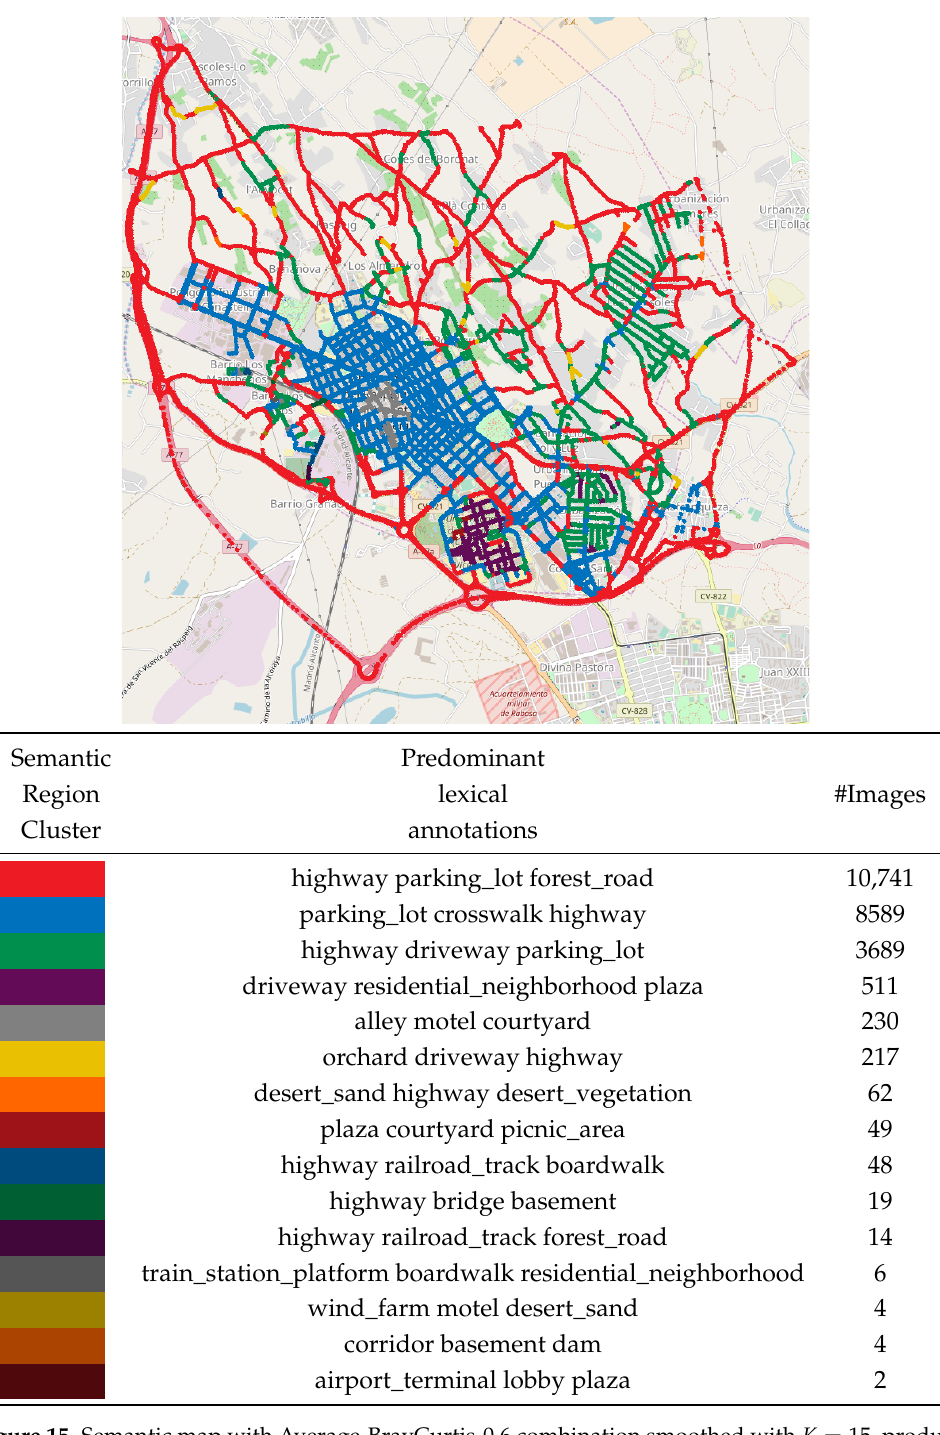
Figure 15. Semantic map with Average-BrayCurtis-0.6 combination smoothed with K = 15, produc- ing 15